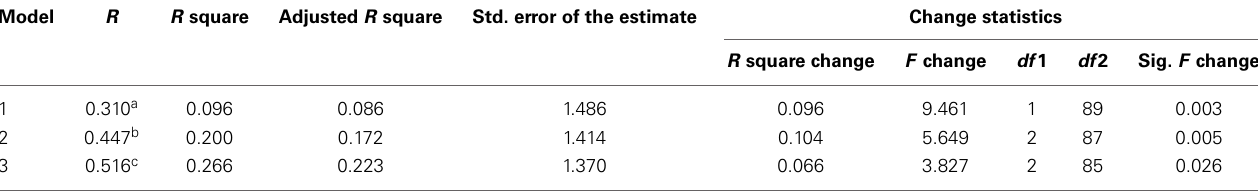
Table 4 | Model and R 2 Change summary predicting IC-A. Model